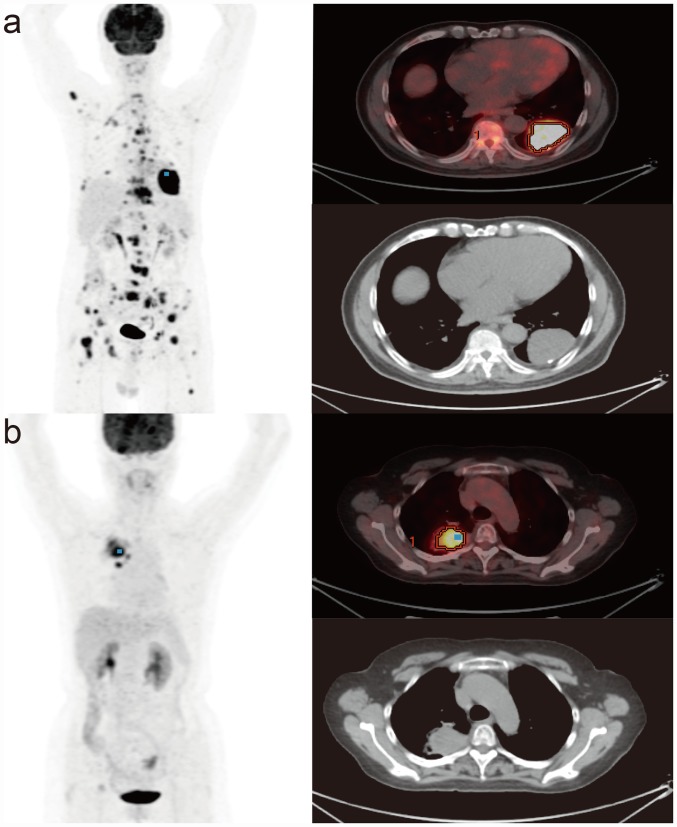
18F-FDG PET/CT in patients with advanced lung adenocarcinoma.a A 71-year-old man with high whole-body total lesion glycolysis (TLGWBR) determined using the Response Evaluation Criteria In Solid Tumors 1.1 criteria (7944.00) and primary tumor total lesion glycolysis (TLGT) (1250.46). Progression-free survival (PFS) was 5.9 months and overall survival (OS) was 11.9 months. EGFR mutation status was the wild-type. b A 68-year-old woman with low TLGWBR (179.74) and TLGT (142.41). PFS was 12.3 months and OS was 35.9 months. EGFR mutation status involved the mutation of exon 19 (delE746-A750).